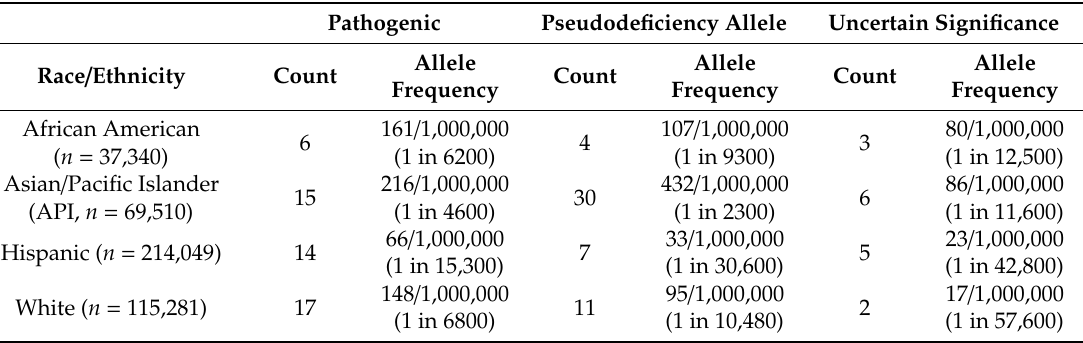
Table 4. Allelic frequency by race /